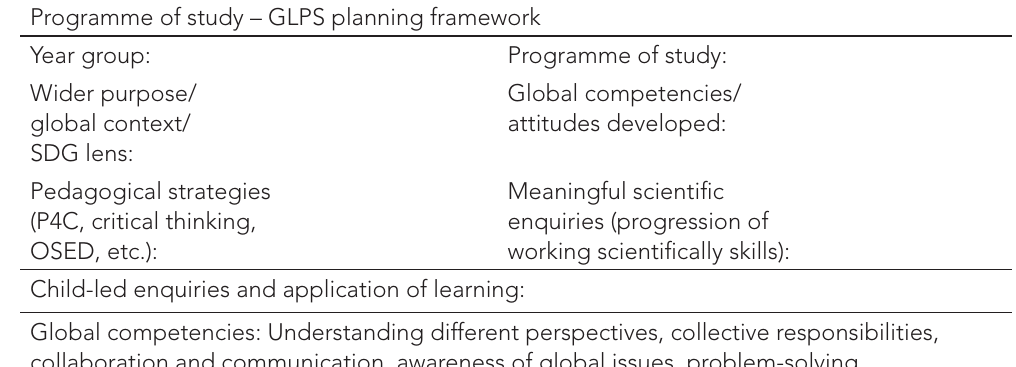
table 1: a framework for integrating SDGs and global learning into programmes